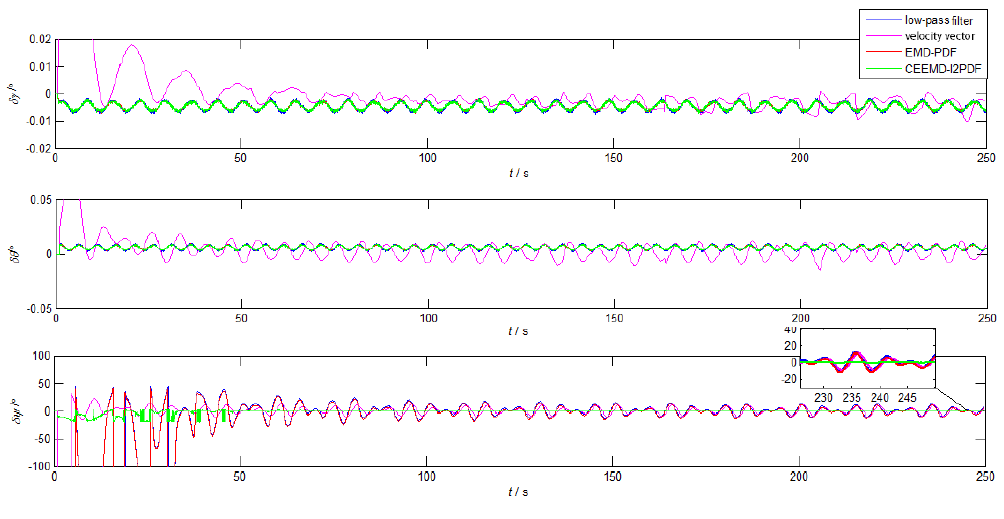
Figure 8. The alignment errors of low-pass, velocity vector, EMD-PDF, and CEEMD- l 2 PDF in simulation.